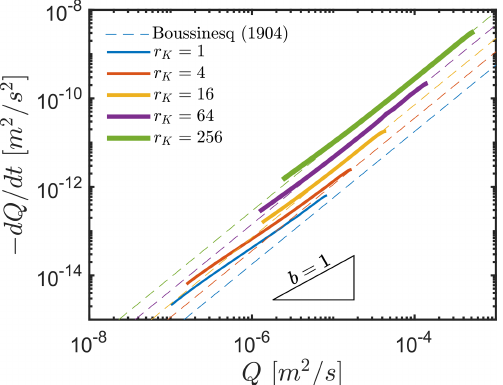
Figure 3. Recession plots displaying − d Q/ d t vs. Q in a log–log space obtained for the horizontal interface, i.e. β = 0, and differ- ent hydraulic conductivity ratios r K . D is fixed at 20m and α at 100m. The dashed lines show predictions for a flat and homoge- neous aquifer, without the deep compartment combining Eqs. (1) and (4) ( b = 15; Boussinesq, 1904). The slope for b = 1, character- istic of the drainage of a linear reservoir, has been drawn for refer-